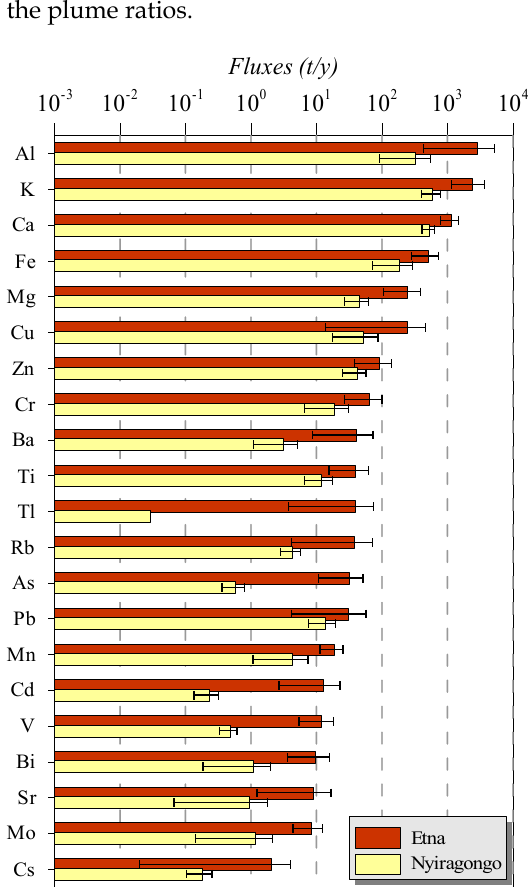
Figure 3: Comparison of Trace element fluxes of Etna and Nyiragongo. Data gained by teflon filter measure- ments at the crater